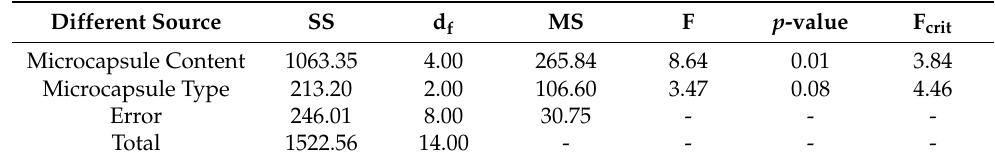
Table 5. Significance analysis of the gloss of coatings with the different content of different shellac microcapsules based on the Beli wood surface.